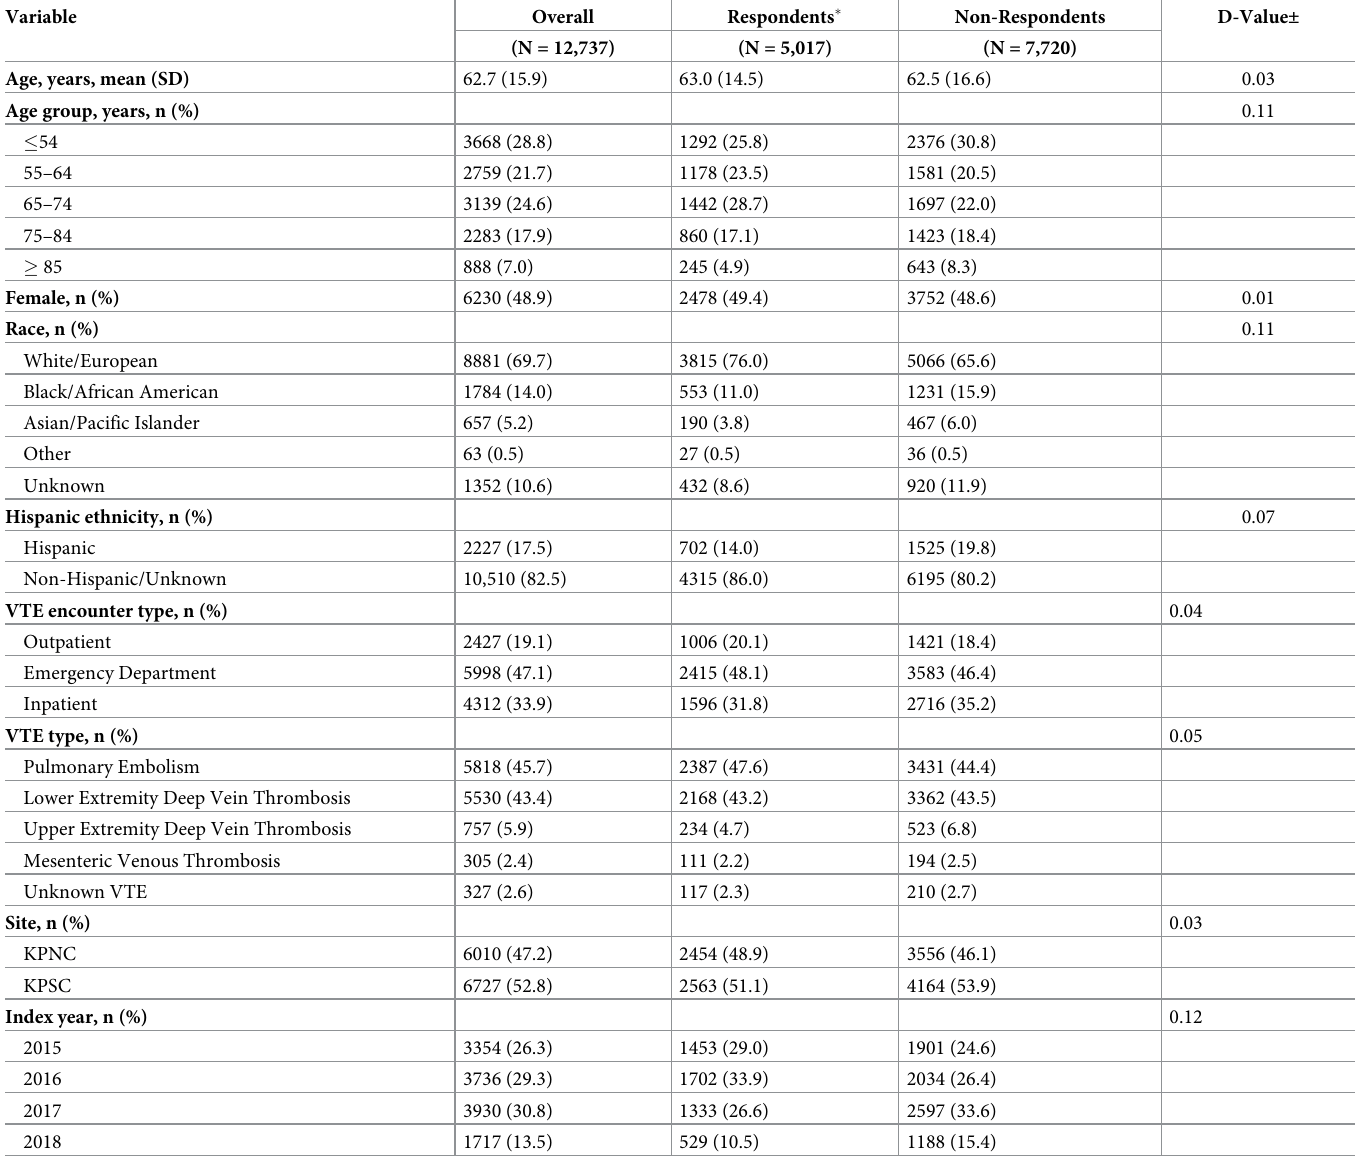
Table 2. Baseline characteristics of respondents and non-respondents in the ALTERNATIVE survey